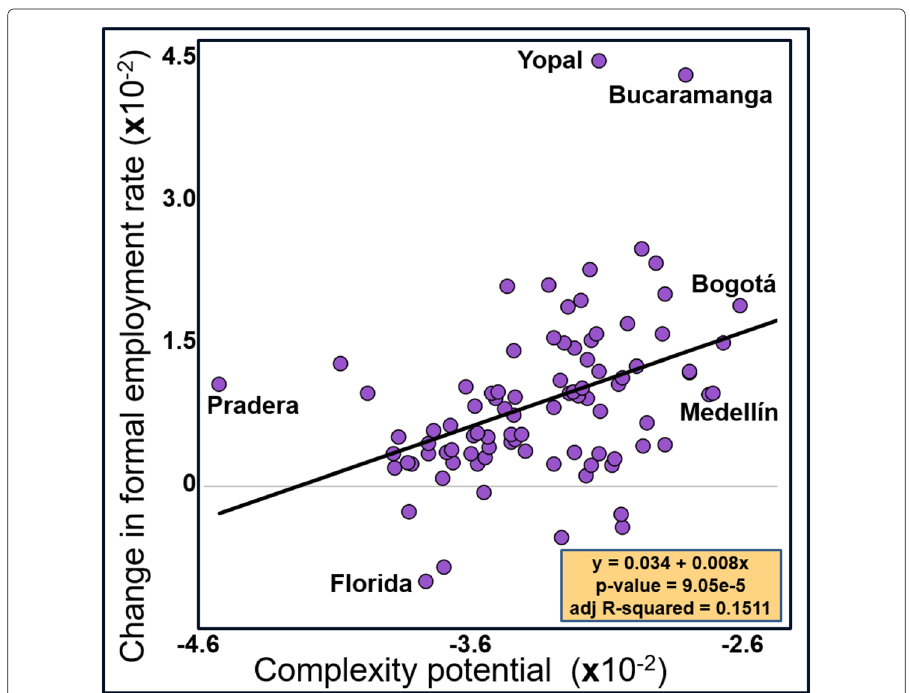
Fig. 11 The relationship between the growth of the formal occupation rate and complexity potential, a measure of the availability of skills to develop more complex industries, for τ = 0 (the number of cities is 96).